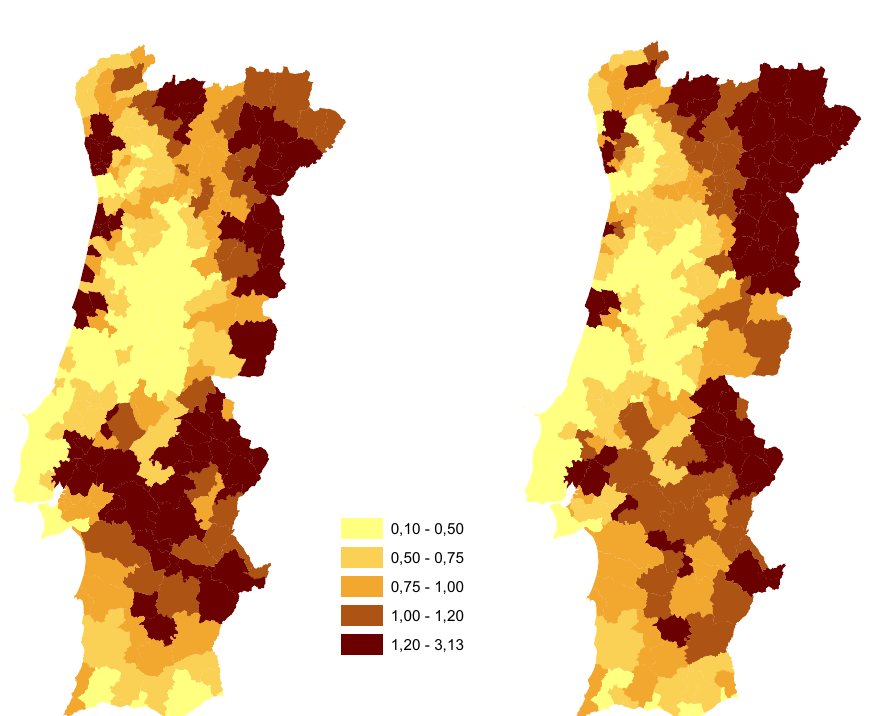
Fig. 3 Distribution of the equity index by municipalities, on the left based on average payments between 2018 and 2020, on the right based on GPP projections for 2026 ( Source : INE data, GPP and authors’